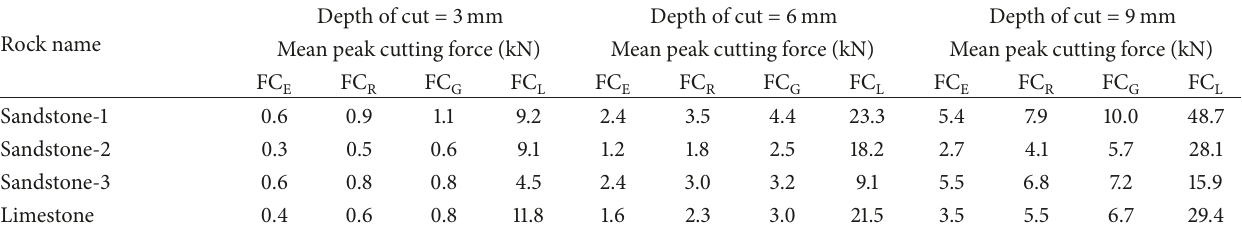
Table 4: The mean peak cutting forces obtained from experimental and theoretical studies [1].